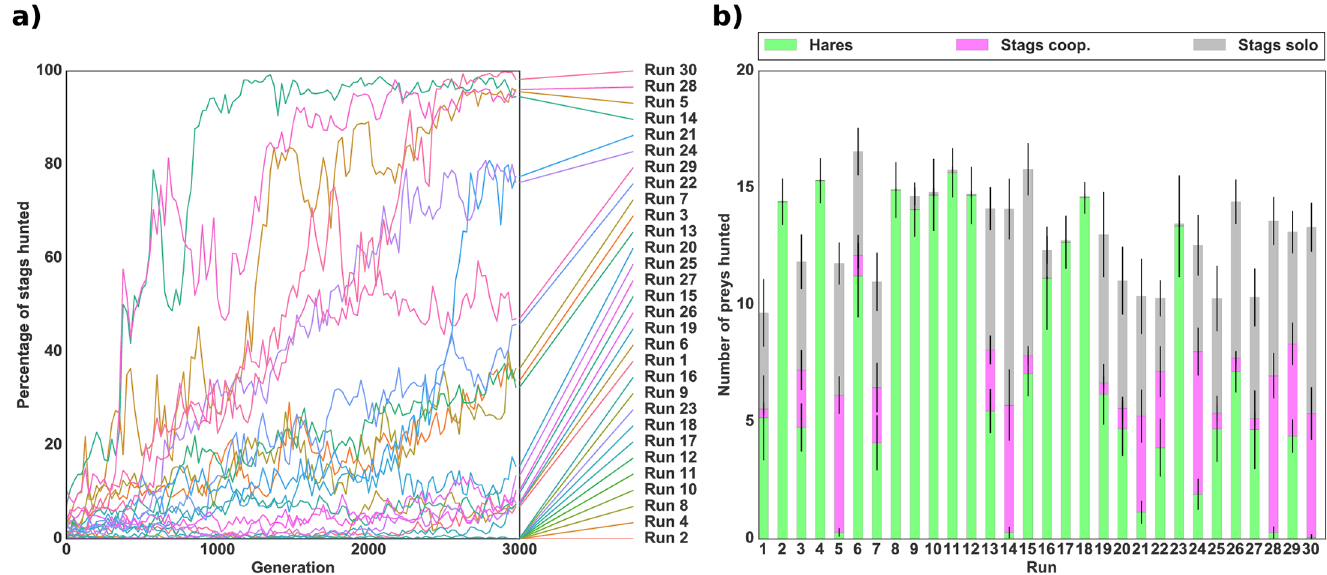
Fig 7. Evolution of cooperation under maximal genetic relatedness with an initial hare-hunting strategy. (a) Evolution of the mean percentage of stags hunted successfully (i.e. cooperatively) with respect to the total number of prey hunted in a robotic simulation. (b) Mean number of prey hunted during the last generation of evolution for each independent run. The bottom green bar represents the number of hares hunted, the middle pink bar the number of stags hunted successfully (cooperatively) and the top grey bar the number of failed hunts (stags hunted alone). The standard deviation for each quantity is shown by black lines. The population for each of the 30 independent runs was previously evolved in an environment with only hares. The genetic relatedness between paired individuals was 1. Rewards were 50 for a hare, 0 for a stag hunted alone, and 500 for a stag hunted cooperatively as presented in Table 1. The number of prey (18) was kept constant throughout the simulation by replacing killed prey by a prey of the same type.